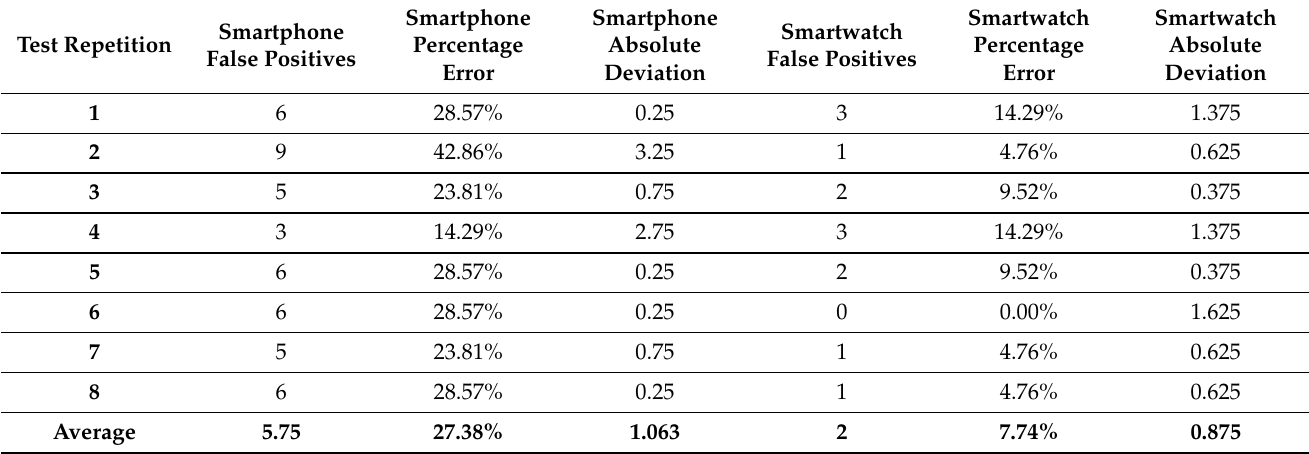
Table 3. Test 3. Percentage error and false